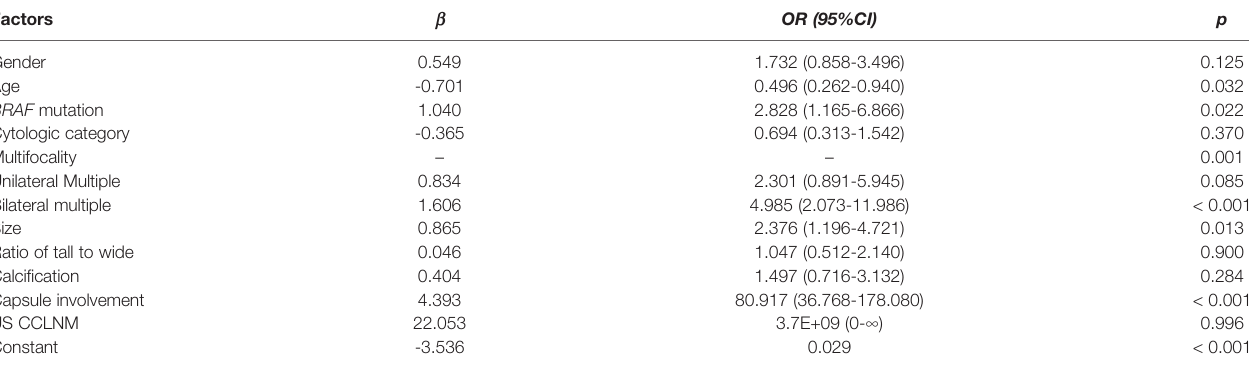
TABLE 3 | Multivariate